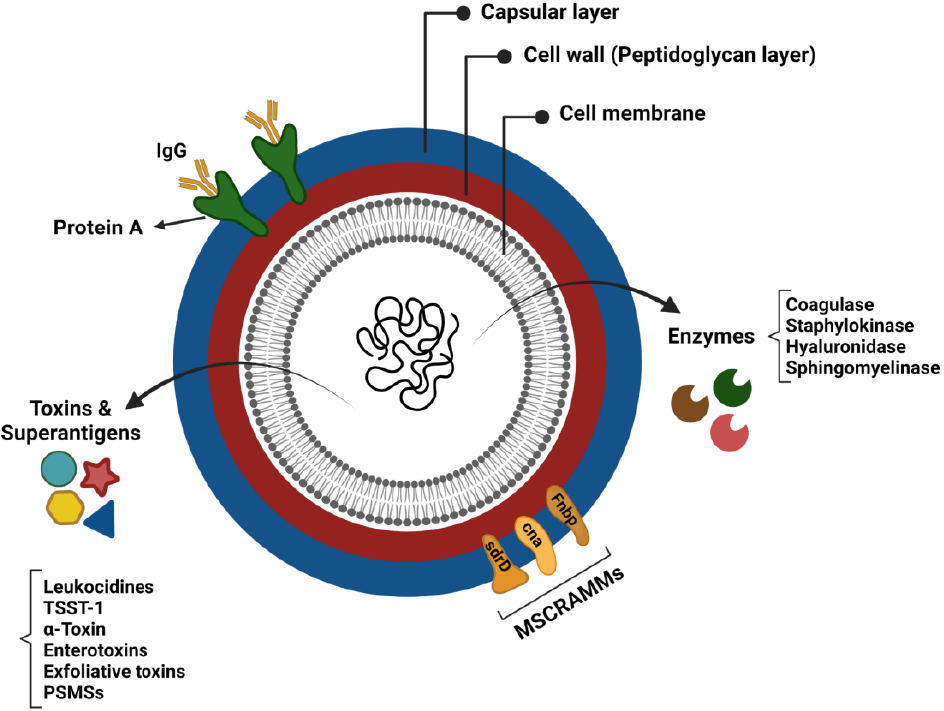
Figure 1. Virulence factors of Staphylococcus aureus .